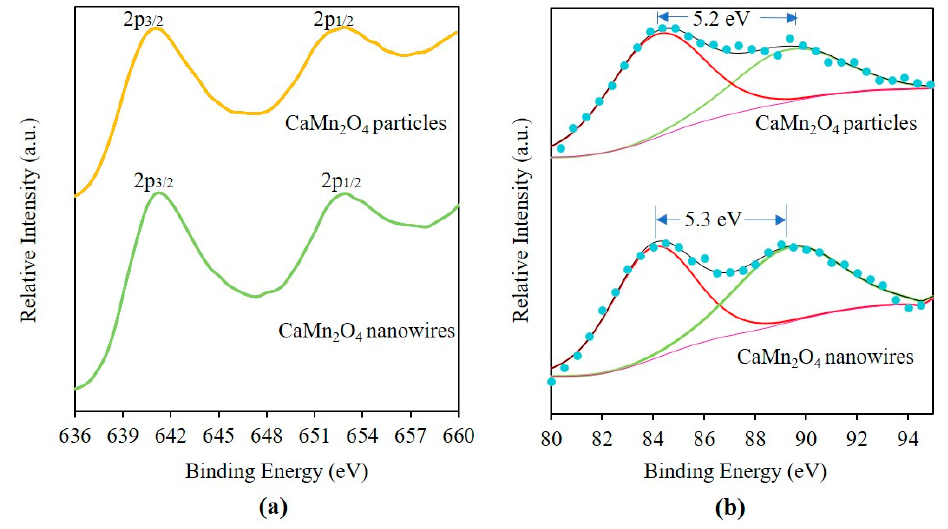
Figure 3. X-ray photoelectron spectroscopy (XPS) spectra of irregular-shaped CaMn 2 O 4 particles and CaMn 2 O 4 nanowires; ( a ) Mn 2p and ( b ) Mn 3s regions.